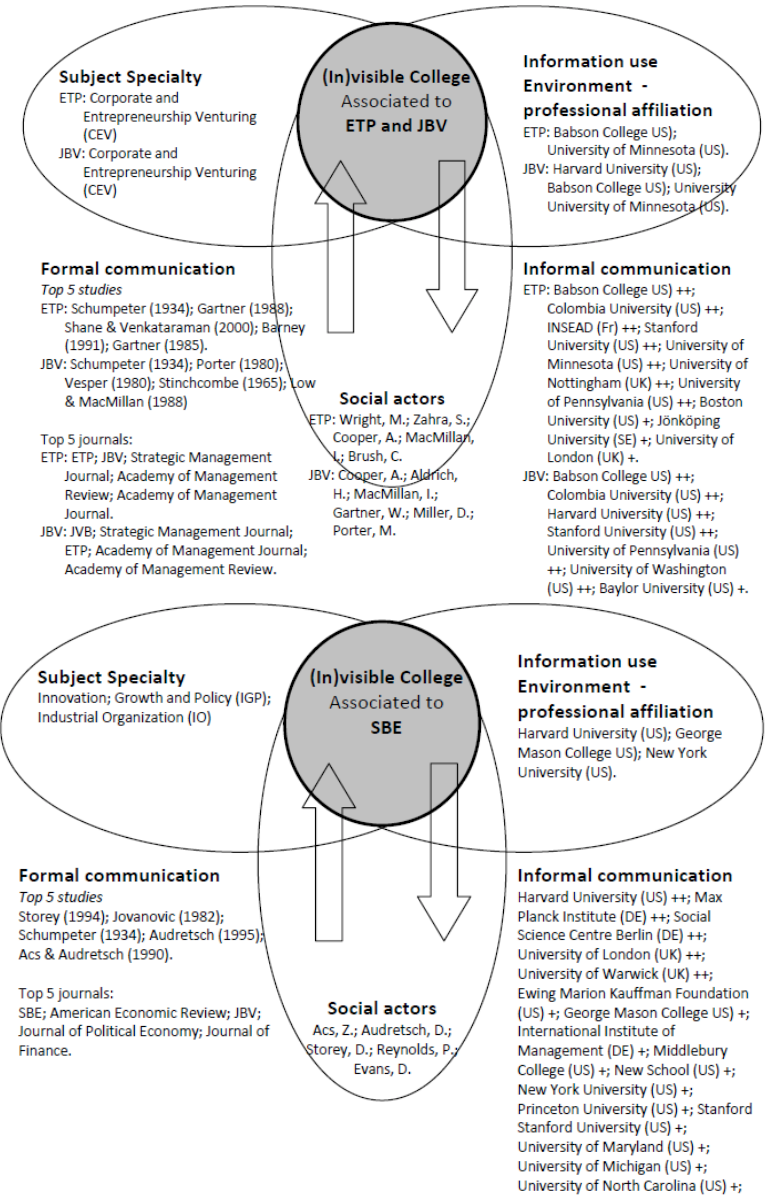
Fig. 5. Invisible colleges in entrepreneurship